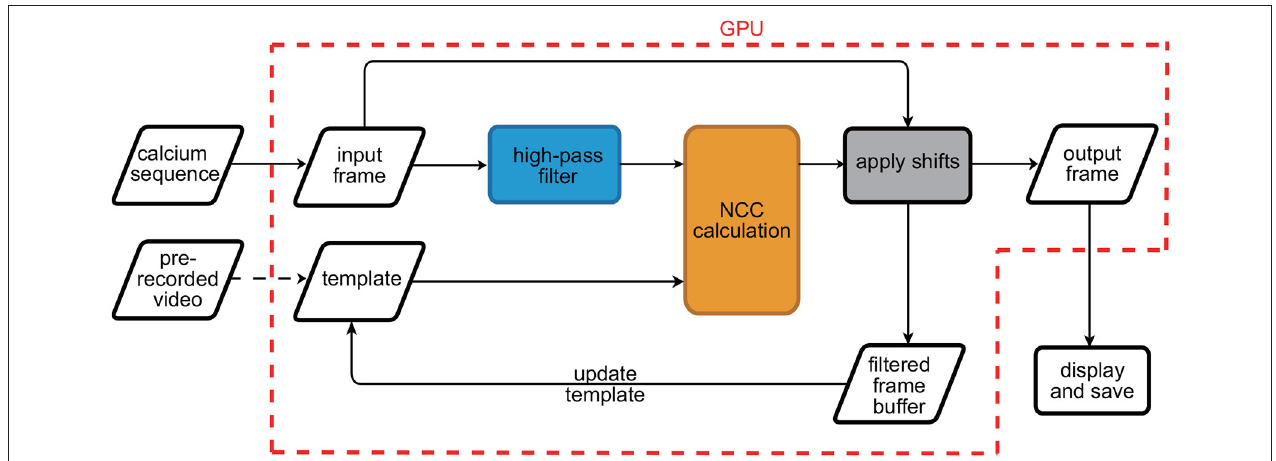
FIGURE 1 | Flow chart of the RTMC algorithm. The initial template is generated based on a prerecorded video. Next, the input frame is copied and filtered. Each filtered frame is aligned with the template and translated with the raw frame. The colored procedures in the chart represent the specific processing in single frame registration. Then, the fixed filtered frame is stored in a buffer to update the template. Finally, the fixed raw frame is output, displayed and saved. The procedures in the red dotted box run on the